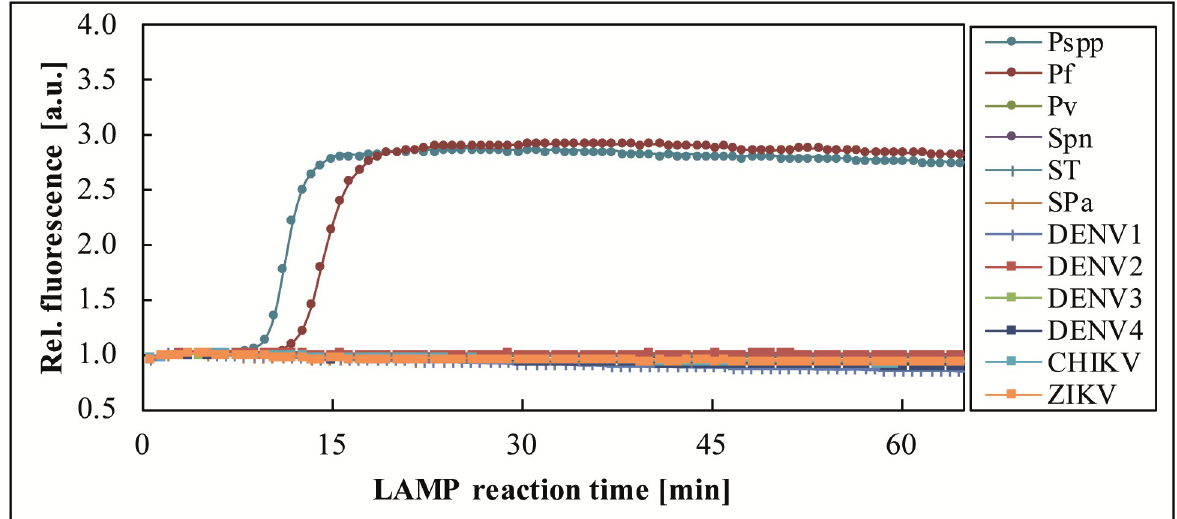
Fig 6. Detection of malaria on a fresh whole blood sample collected in real time. Positive signal for Pf and P spp was confirmed as true positive with microscopy blood smear test.